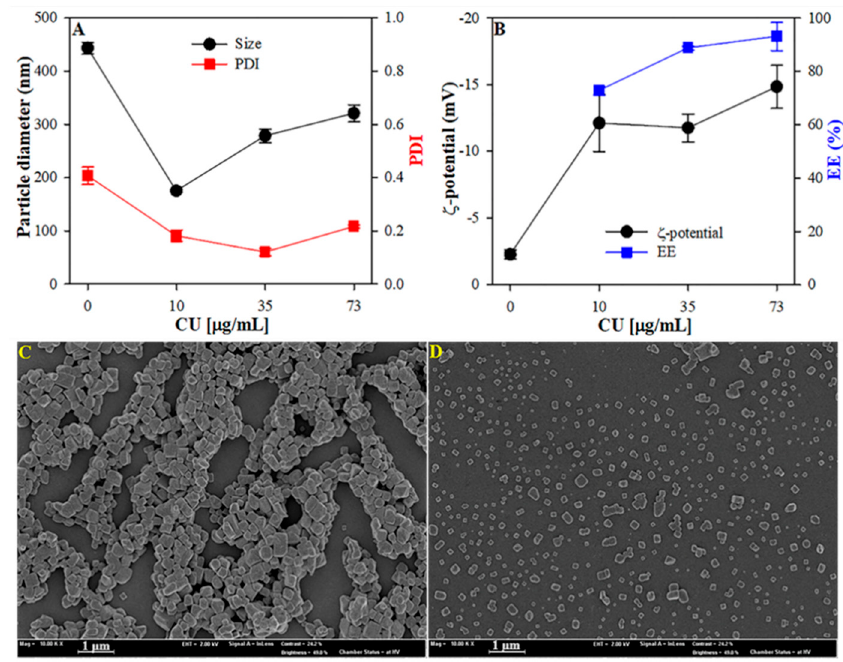
Figure 1. Fabrication of stable and homogeneous CUHNP. Particle size, PDI ( A ), ζ -potential, and encapsulation efficiency ( B ) of CUHNP as a function of CU concentration and SEM images of HSA ( C ) and CUHNP ( D ) nanoparticles.